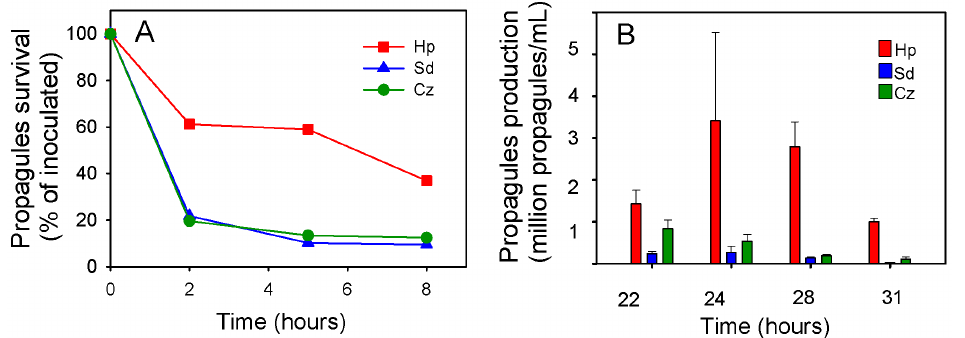
Figure 5. Fitness parameters of the parasite in coculture of H. pluvialis (Hp), C. zofingiensis (Cz) and S. dimorphus (Sd) inoculated with same number of purified propagules. ( A ) Propagule survival measured in the first hours after inoculation as the sum of free-swimming propagules and encysted ones; ( B ) Propagule production counted in hemacytometer. The same cultures were used to assess propagule survival and propagule production, and in each coculture, the same number of propagules was inoculated in different microalgal densities adjusted to offer the same algal surface area. Data pre- sented in this figure are from cultures shown in Figure 3B. Letters indicate statistical significance ( p value < 0.05).